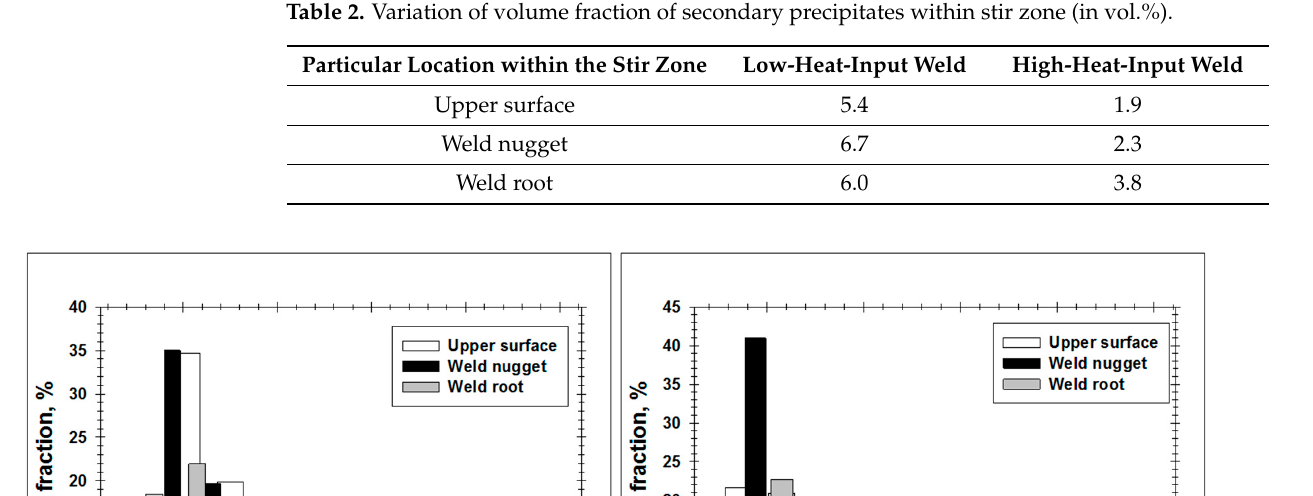
Figure 6. The precipitate-size distributions measured in different locations of ( a ) low-heat-input weld and ( b ) high-heat-input weld.